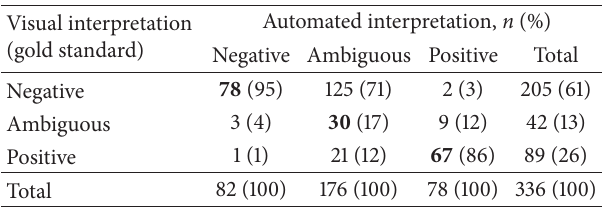
Table1:Visualversusautomateddetectionofantinuclearantibodies by indirect immunofluorescence. Crosstabulation of the results of the visual (gold standard) versus automated interpretation of antin- uclear antibodies (ANA) detected by indirect immunofluorescence (IIF) for 336 serum samples utilizing the ANA-IIF-assay